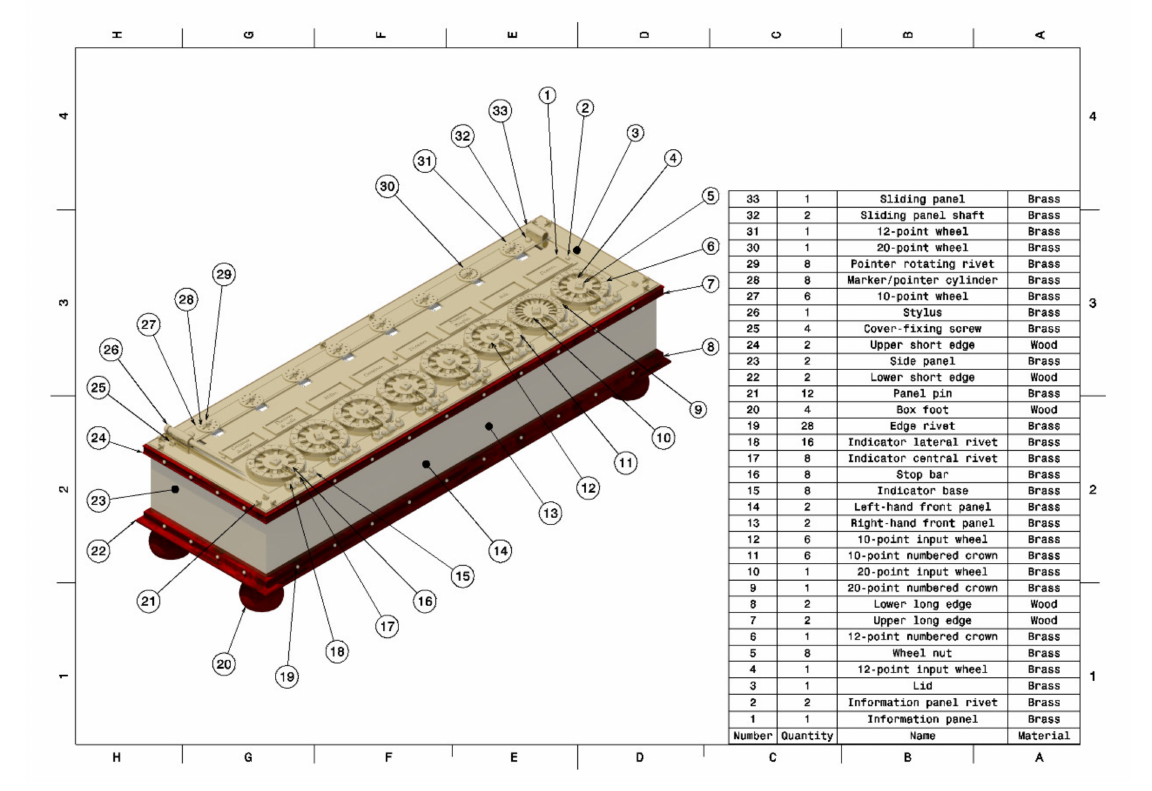
Figure 2. Assembly plan for the Pascaline (Elements 1–33).